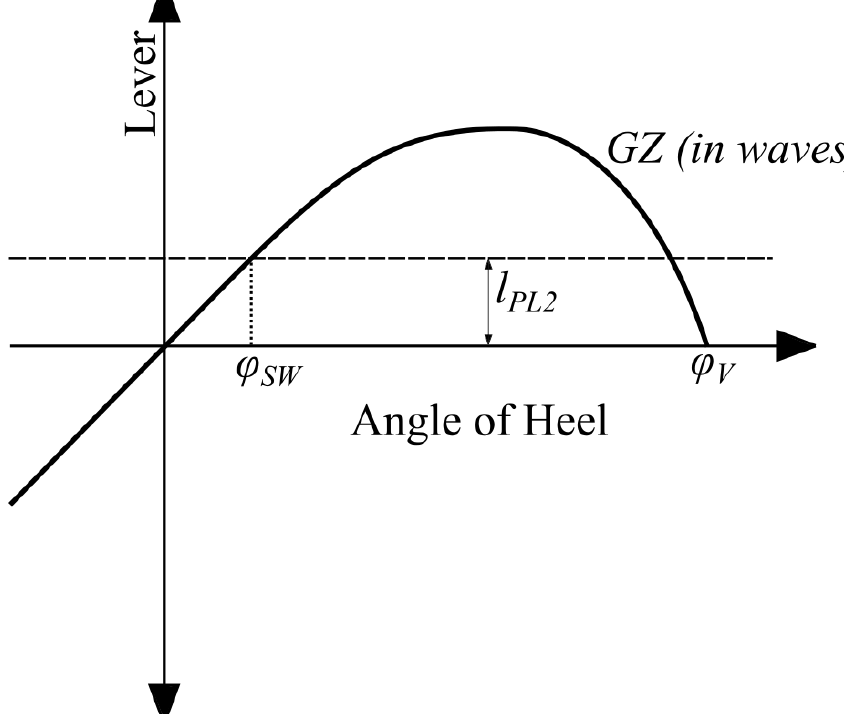
Figure 10. Pure loss of stability level 2 righting arm definitions. Note that multiple GZ curves are computed in different quasi-static wave